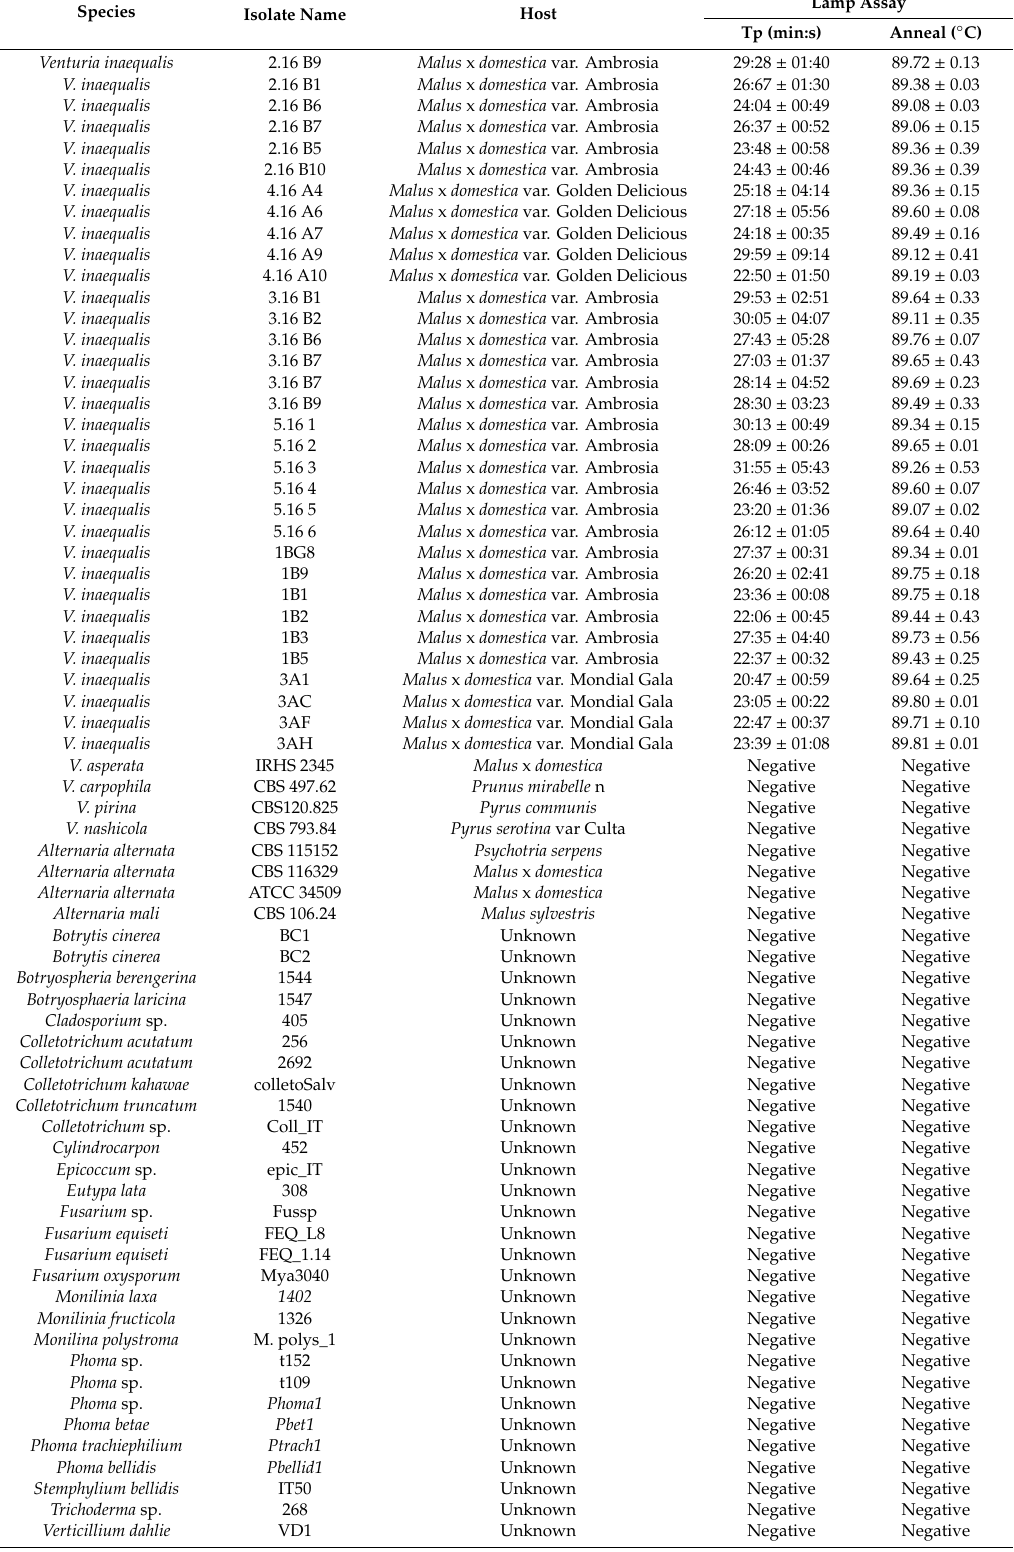
Table 1. Inclusion–exclusion panel to check the specificity of the loop-mediated isothermal amplification (LAMP) assay using DNA of V. inaequalis , phylogenetically related species and other common pathogens present in apple